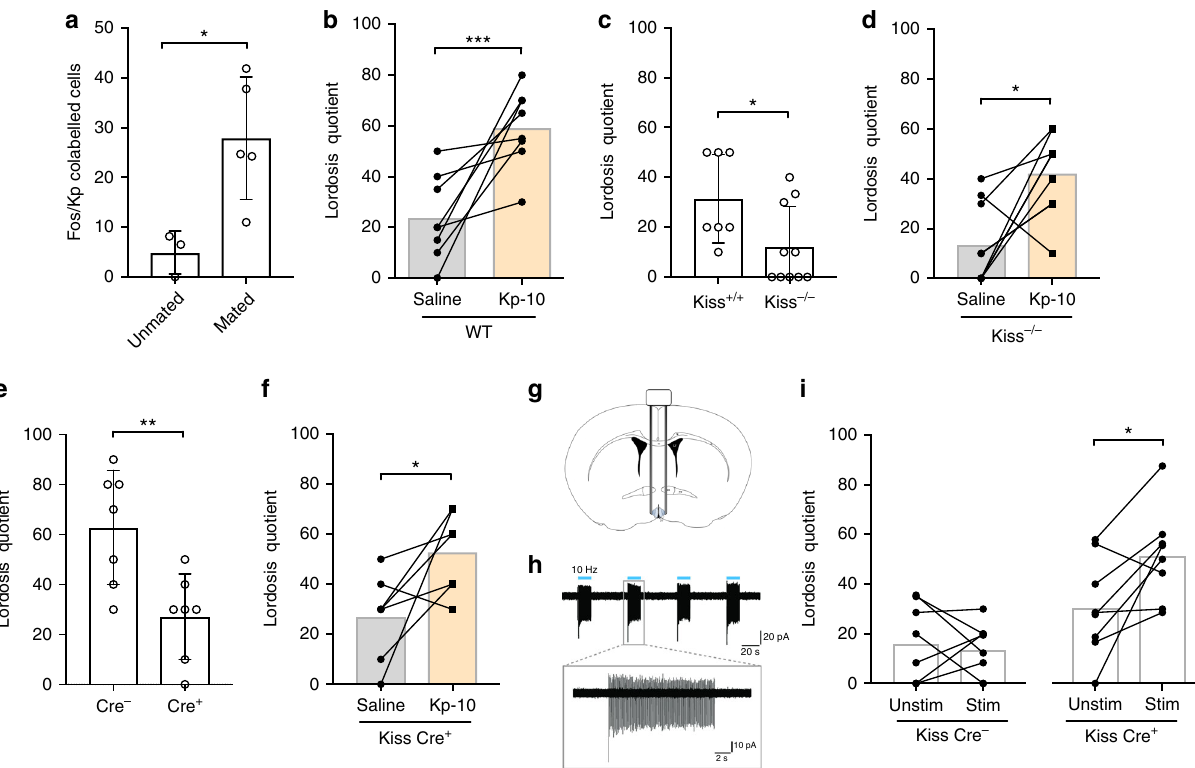
Fig. 2 RP3V kisspeptin neurons are an important component of the neural network regulating lordosis behavior. a Mating speci fi cally activated kisspeptin neurons in the RP3V of ovary intact female mice as determined by the percentage of Fos/Kp co-labeled cells. * P ≤ 0.05; unpaired t test; n = 3/5. b A peripheral injection of kisspeptin-10 (Kp-10) at a dose of 0.52 µ g kg − 1 stimulated lordosis behavior. *** P ≤ 0.001; paired t test; n = 8 per group. c Lordosis behavior is attenuated in kisspeptin knockout ( Kiss − / − ) mice. Please note that the background strain of Kiss + / + and Kiss − / − mice is 129SvJ , which showed overall lower levels of lordosis behavior compared to C57Bl / 6J mice. * P ≤ 0.05; Mann – Whitney U test; n = 7/10. d A peripheral injection with Kp-10- induced lordosis behavior in Kiss − / − females. * P ≤ 0.05; paired t test; n = 9. e – f Stereotaxic injection with an AAV encoding a Cre-dependent caspase bilaterally into the RP3V decreased lordosis behavior, but was restored by a peripheral Kp-10 injection. e ** P ≤ 0.01; unpaired t test; * P ≤ 0.05. f Paired t test; n = 7 per group. g Anatomical drawing showing the position of the bilateral cannula holding optical fi bers with 45° oriented mirrors tip into the RP3V. h Blue light photostimulation (10 Hz, 473 nm) elicited robust fi ring of kisspeptin neurons in KissIC mice brain slices, which were injected with an AAV encoding a Cre-dependent channelrhodopsin (AAV-ChR2) bilaterally into the RP3V. i Blue light photostimulation (Stim) increased the expression of lordosis behavior in KissIC mice, which were injected with AAV-ChR2 bilaterally into the RP3V. * P ≤ 0.05, paired t test; n = 8 per group ( Kiss Cre − and Kiss Cre + ). Bars represent the mean ± SEM. For all experimental details, see Supplementary Table light photostimulation (1 – 15 s at 10 Hz) elicited robust fi ring in virally transduced kisspeptin neurons with spike fi delity of 99% (Fig. 2h) in brain slice preparations. Photostimulation of RP3V kisspeptin neurons in vivo at 10 Hz for < 15 s per male mount also was successful in enhancing lordosis behavior in Cre + (OVX+E) female mice (paired t test; P = 0.025; Fig. 2i) without enhancing lordosis expression in Cre − (OVX+E) female mice injected with the AAV-ChR2 virus (paired t test; P = 0.72; Fig. 2i). Taken together, our experiments demonstrate that RP3V kisspeptin neurons are an integral part of the neural network involved in both mate preference and lordosis behavior in female mice.